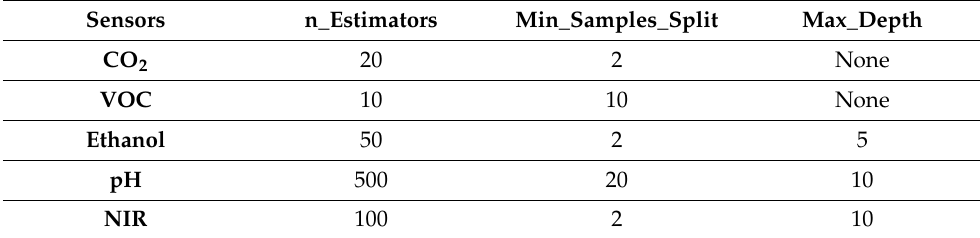
Table 2. Best Model Parameters Random Forest